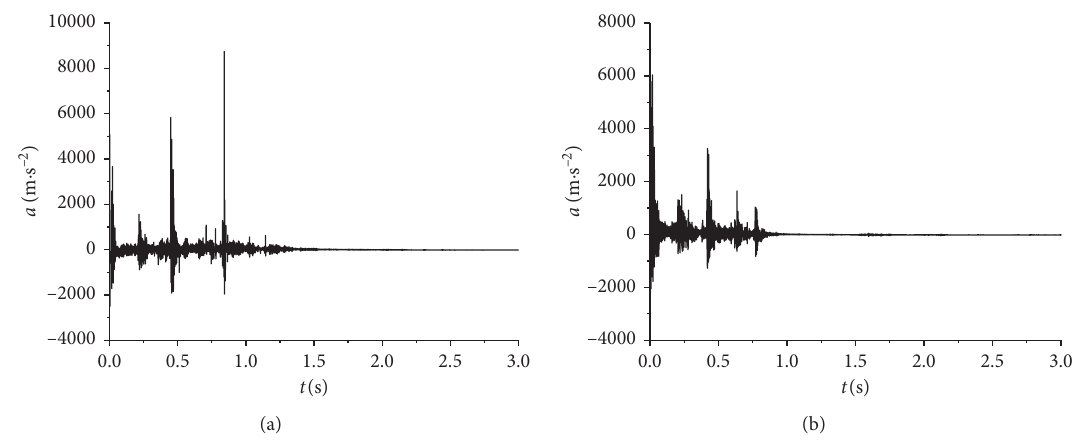
Figure 5: Measured acceleration time-history curves of spring-rubber isolation device. (a) TXJG1. (b) TXJG2.